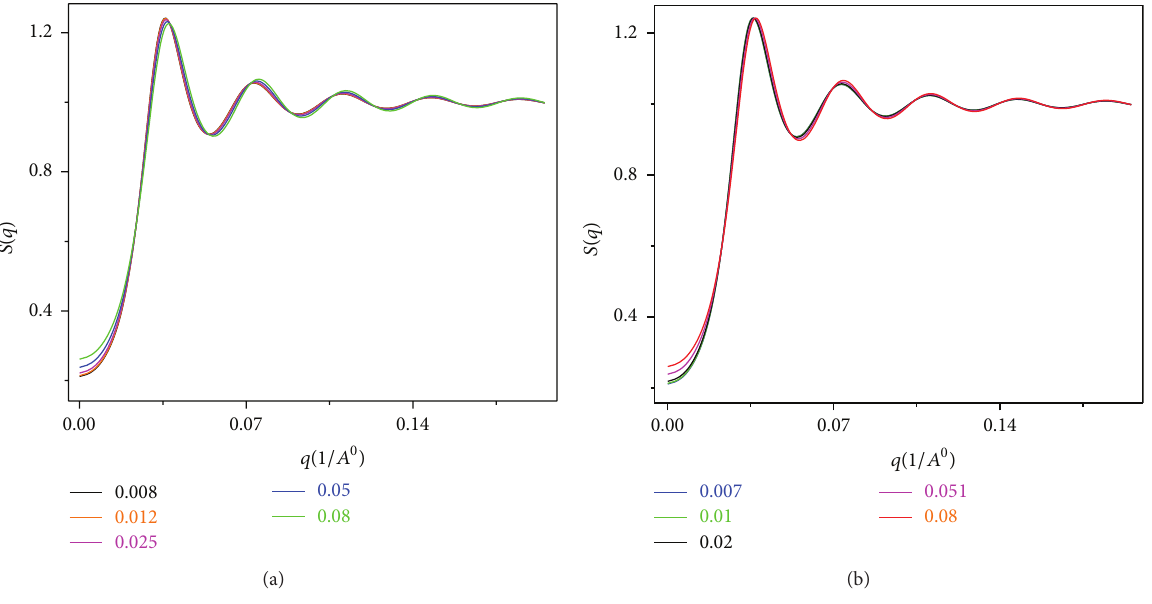
Figure 4: The structure factor of a mixture of C 12 E 5 /water/n-decane PCL at a constant droplet mass fraction (0.2) and 𝑚 with different concentrations of PCL. (a) PCL with M.W. = 5000 and (b) PCL with M.W. = 10000.